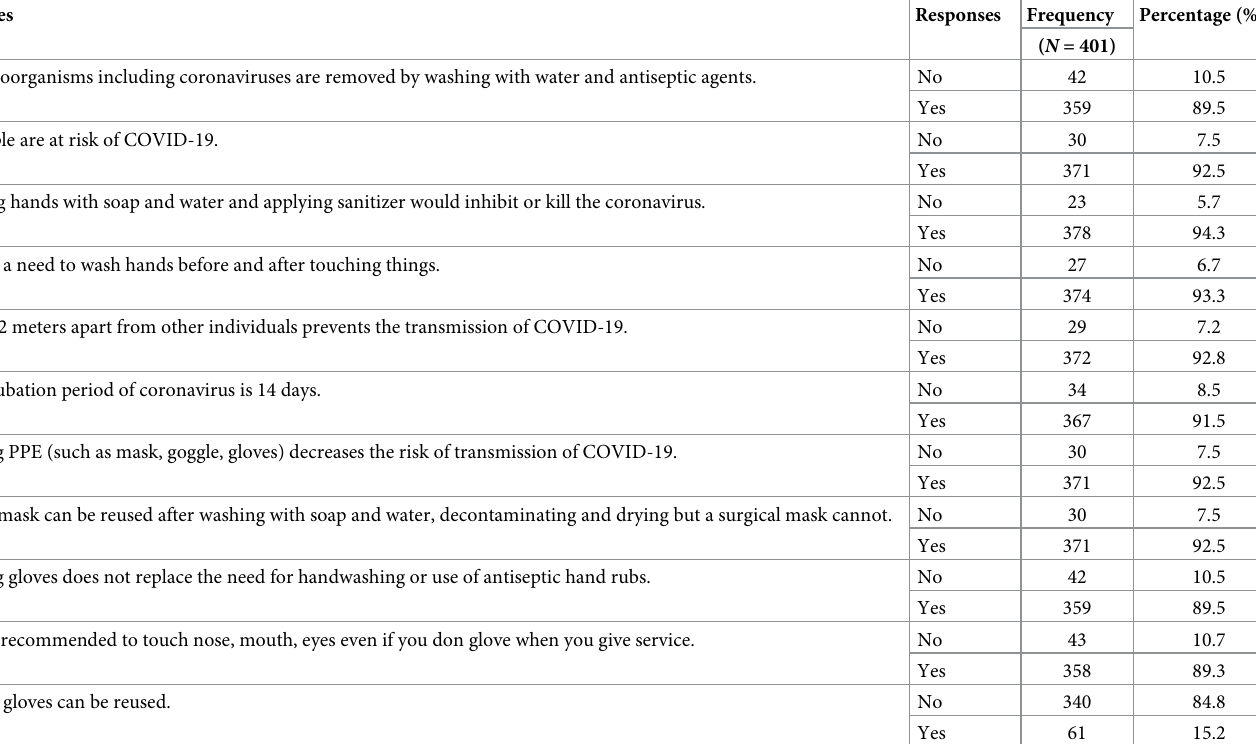
Table 5. Frequency and percentage distribution of attitude towards COVID-19 infection prevention practices among food handlers at food and drink establish- ments in Dessie City and Kombolcha Town, Northeastern Ethiopia, July–August 2020. Attitude variables Strongly